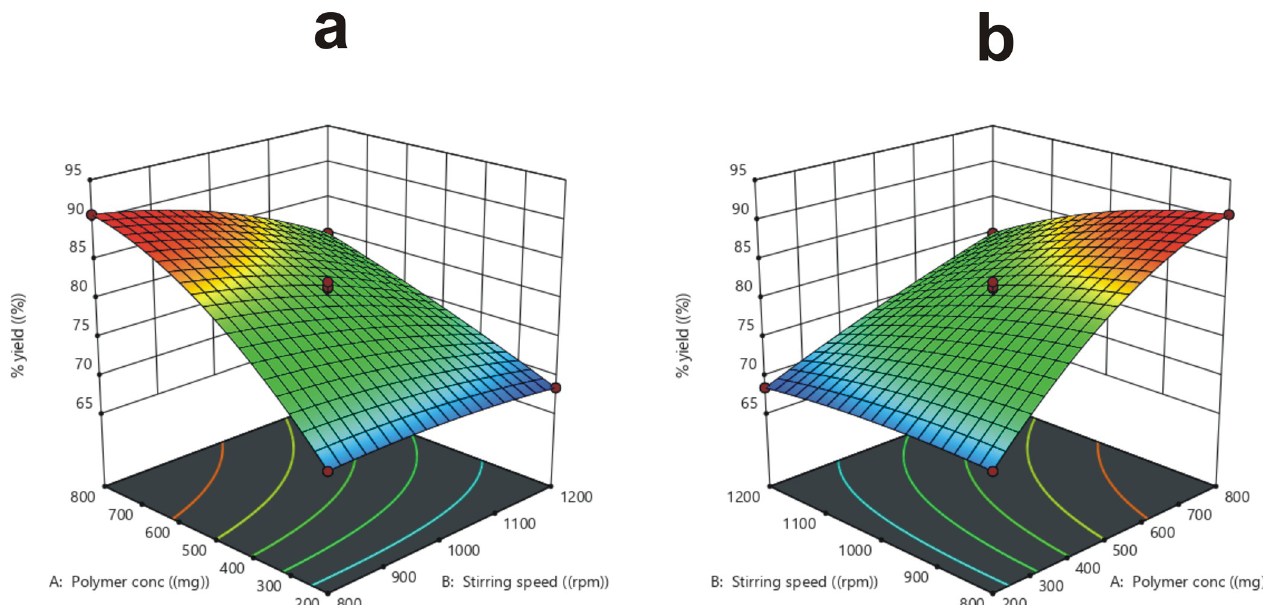
Fig 1. The influence of polymer concentration and stirring speed on percentage yield (a), the influence of surfactant conc and polymer conc on percentage yield